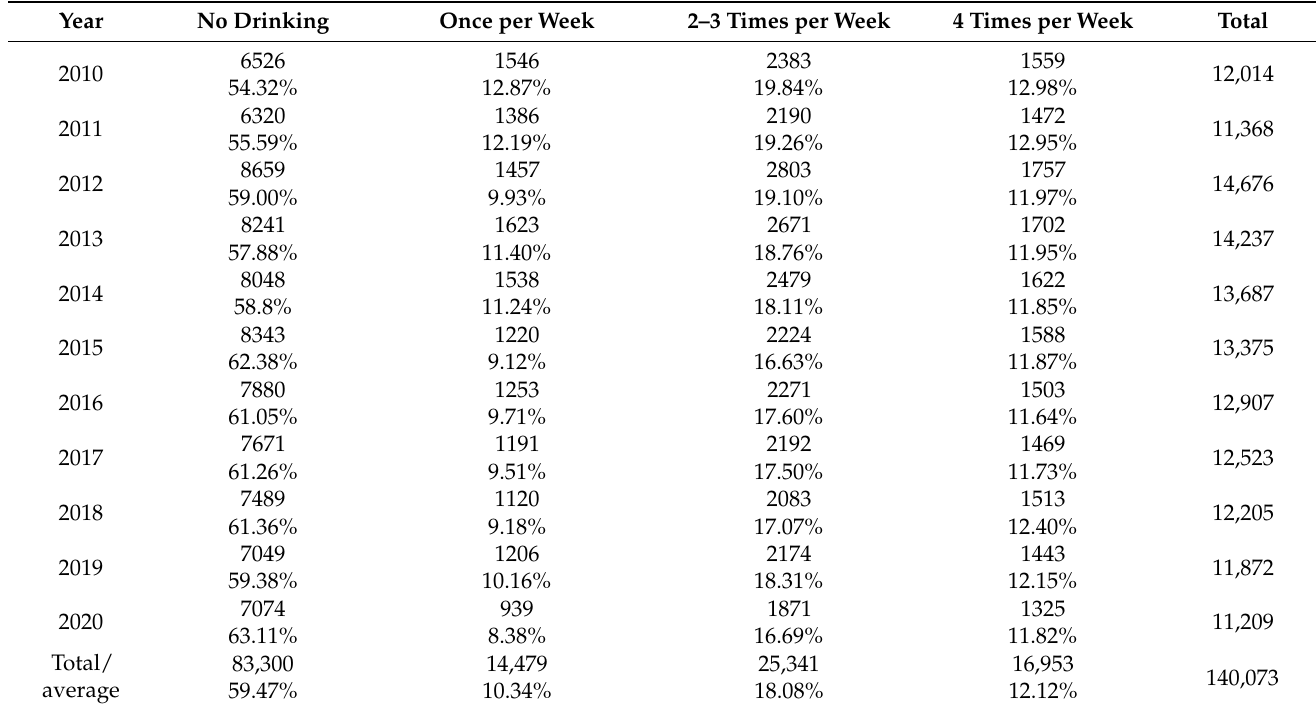
Table 2. Drinking frequency in 2010 − 2020.